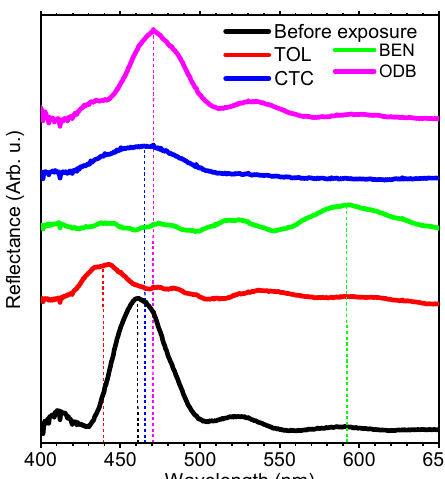
Figure 3. Reflectance spectra of ZnONP@PS @CA DBRs collected before (black line) and after 10 min of exposure to vapors of TOL (red), BEN (green), CTC (blue), o-DCB (magenta).